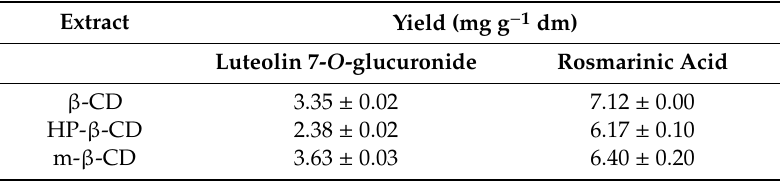
Table 10. Quantitative data on the recovery of major S. fruticosa polyphenols with the CDs tested, under optimal conditions.